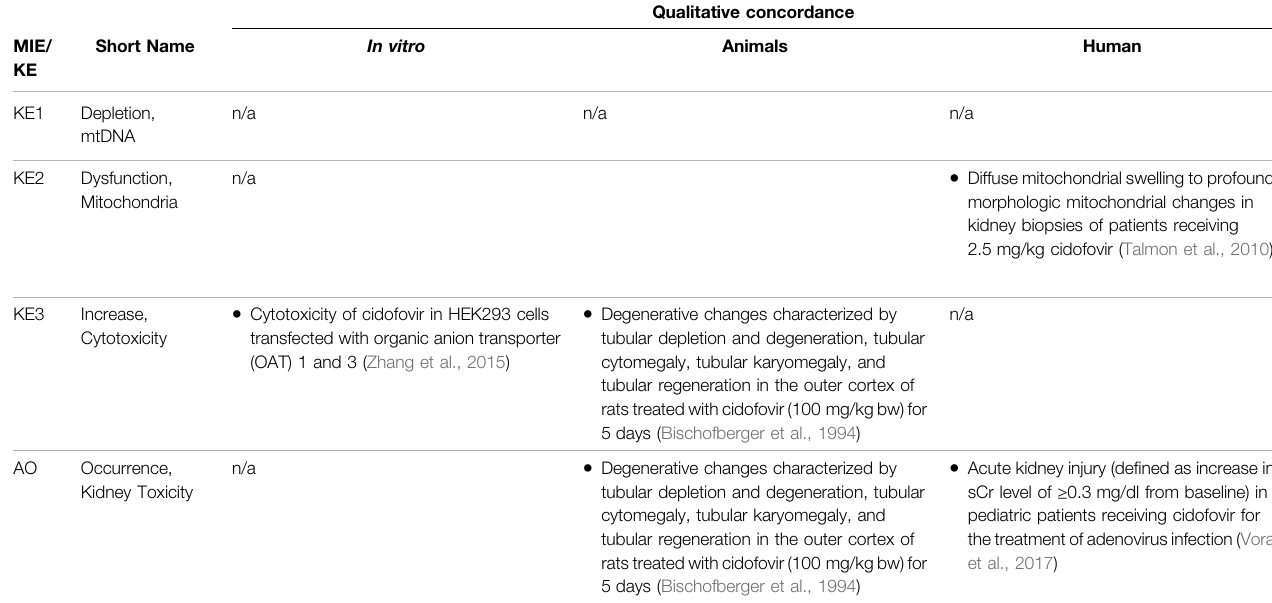
TABLE 1C | Evidence from human, animal and in vitro studies on cidofovir supporting the key events and qualitative concordance of KEs within this AOP (n/a = no data available).